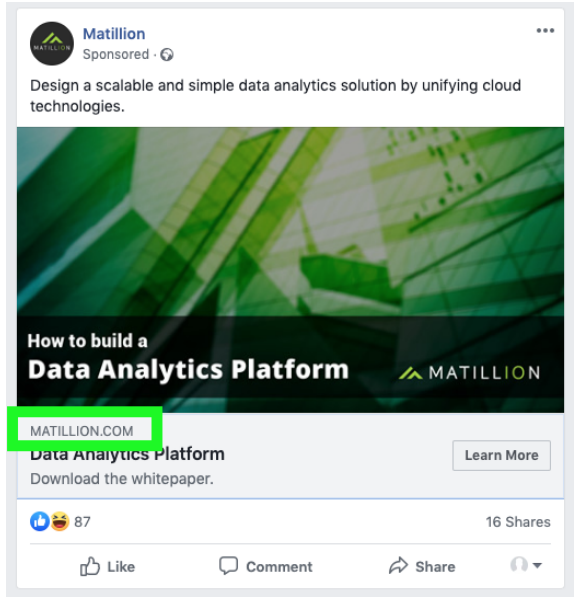
Figure 4. Ad example that illustrates where the lading domain information is embedded in the ad using a green